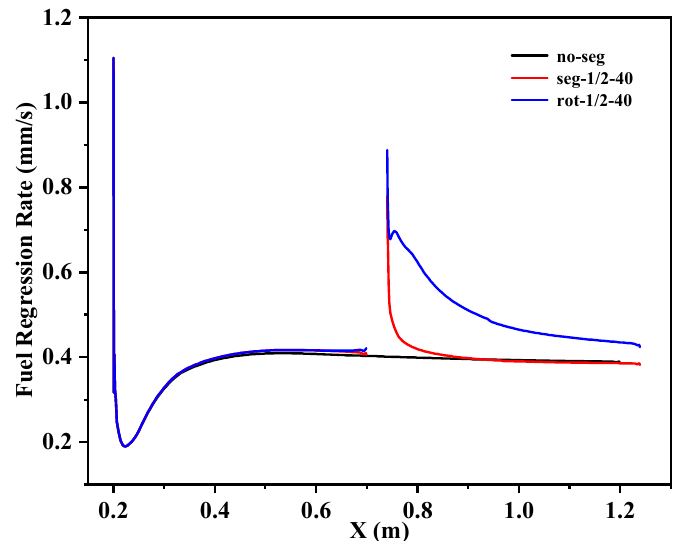
Figure 22. Fuel regression rates of point c (defined in Figure 2) along the motor axis in various cases.